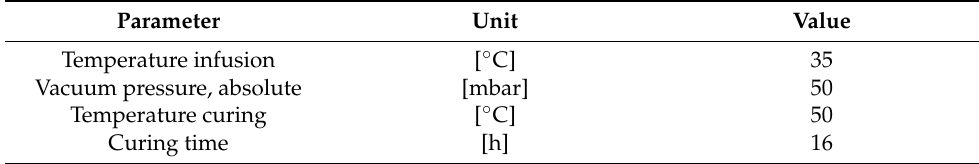
Table 3. Infiltration process parameters and curing